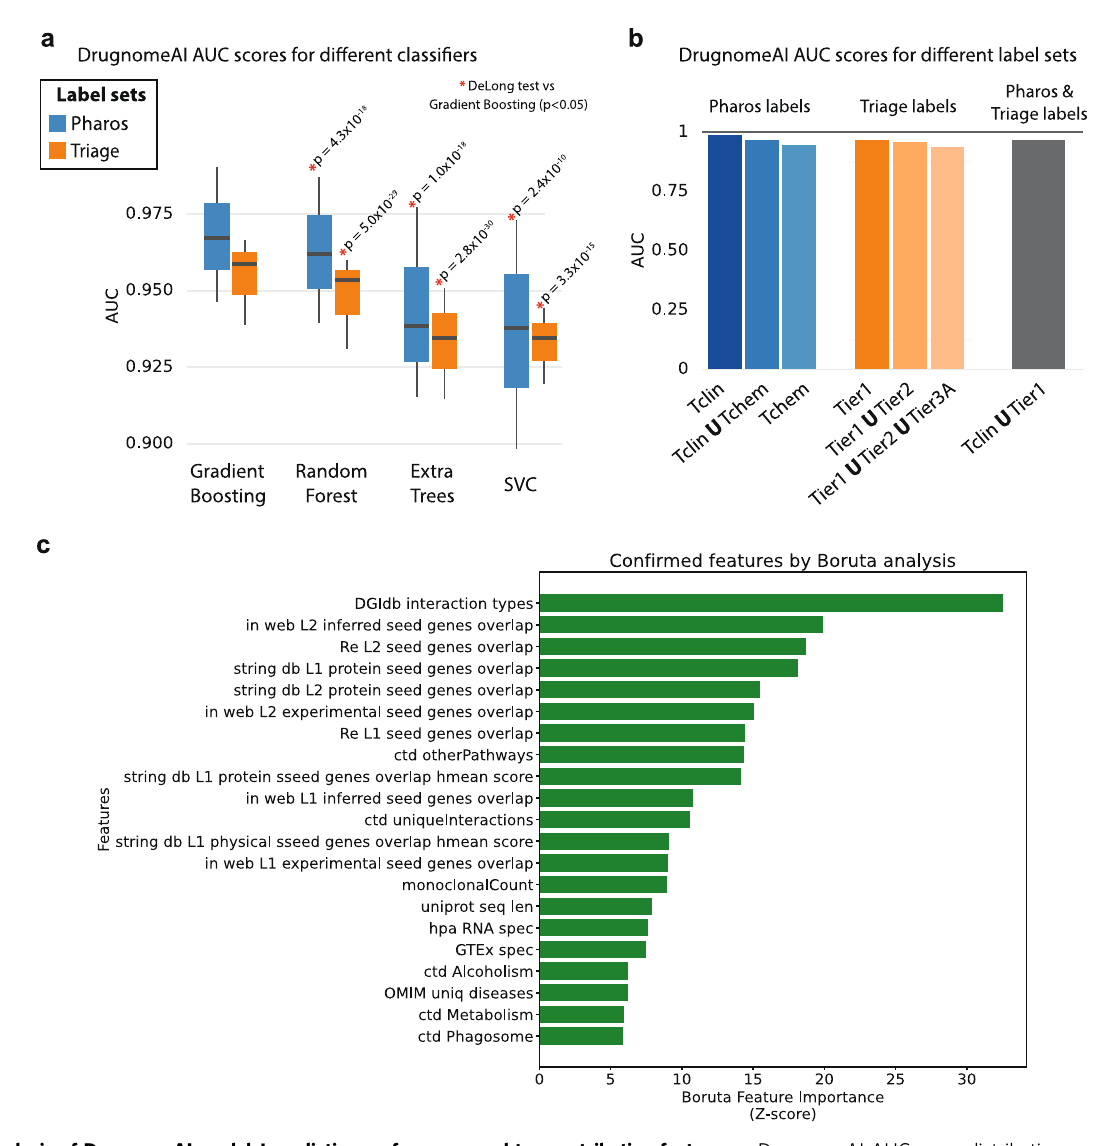
Fig. 2 Analysis of DrugnomeAI models' predictive performance and top contributing features. a DrugnomeAI AUC score distribution across different classi fi ers and labelling variants utilising the druggability-speci fi c dataset (the statistical signi fi cance of Gradient Boosting outperforming the other classi fi ers has been calculated using DeLong test, with the corresponding p values provided above each barplot). b AUC scores (with Gradient boosting) across different labelling variants utilising the druggability-speci fi c dataset. c List of druggability-associated features extracted by the Boruta feature selection algorithm (as “ Con fi rmed ” features) on the Tclin